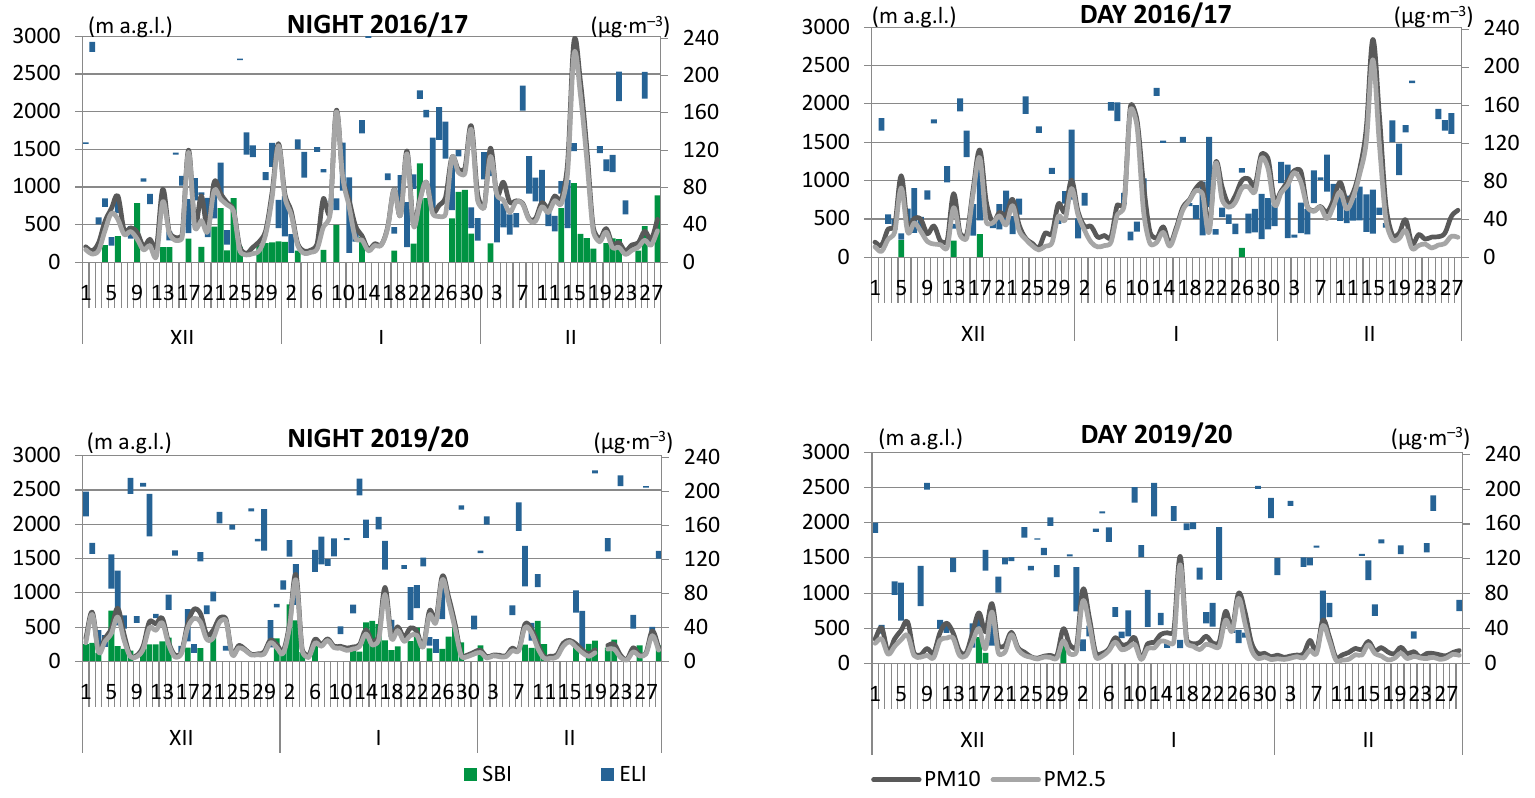
Figure 6. Distribution of the night-time and daytime concentration of PM 10 and PM 2.5 in Wrocław in relation to the course of TI; winter 2016/17 and 2019/20.